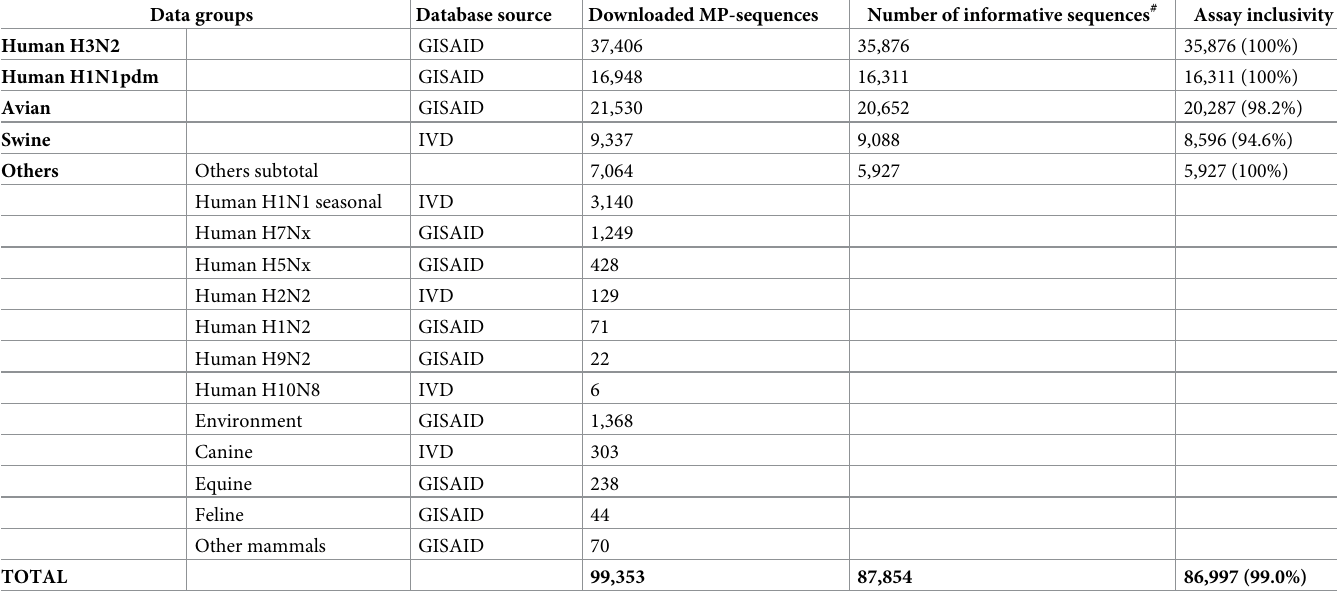
Table 2. The MP-segment data groups, database origin and SVIP-MPv2 assay theoretical inclusivity values. Data